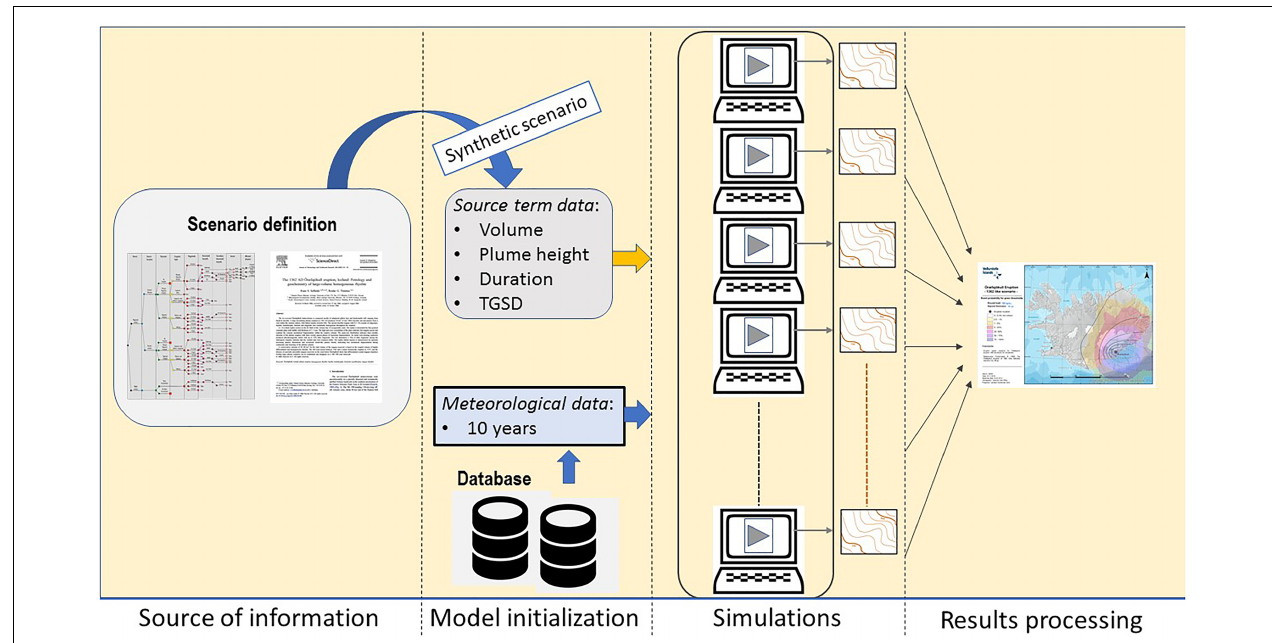
FIGURE 2 | The four main steps at the base of this study. It starts with the identification of the scenario of interest (and its volcanological parameters), the synthetic scenario is designed to fulfill the need of input data required to run the numerical model, several simulations are executed by using different meteorological conditions in input and finally the multitude of results are integrated in one single probabilistic map.